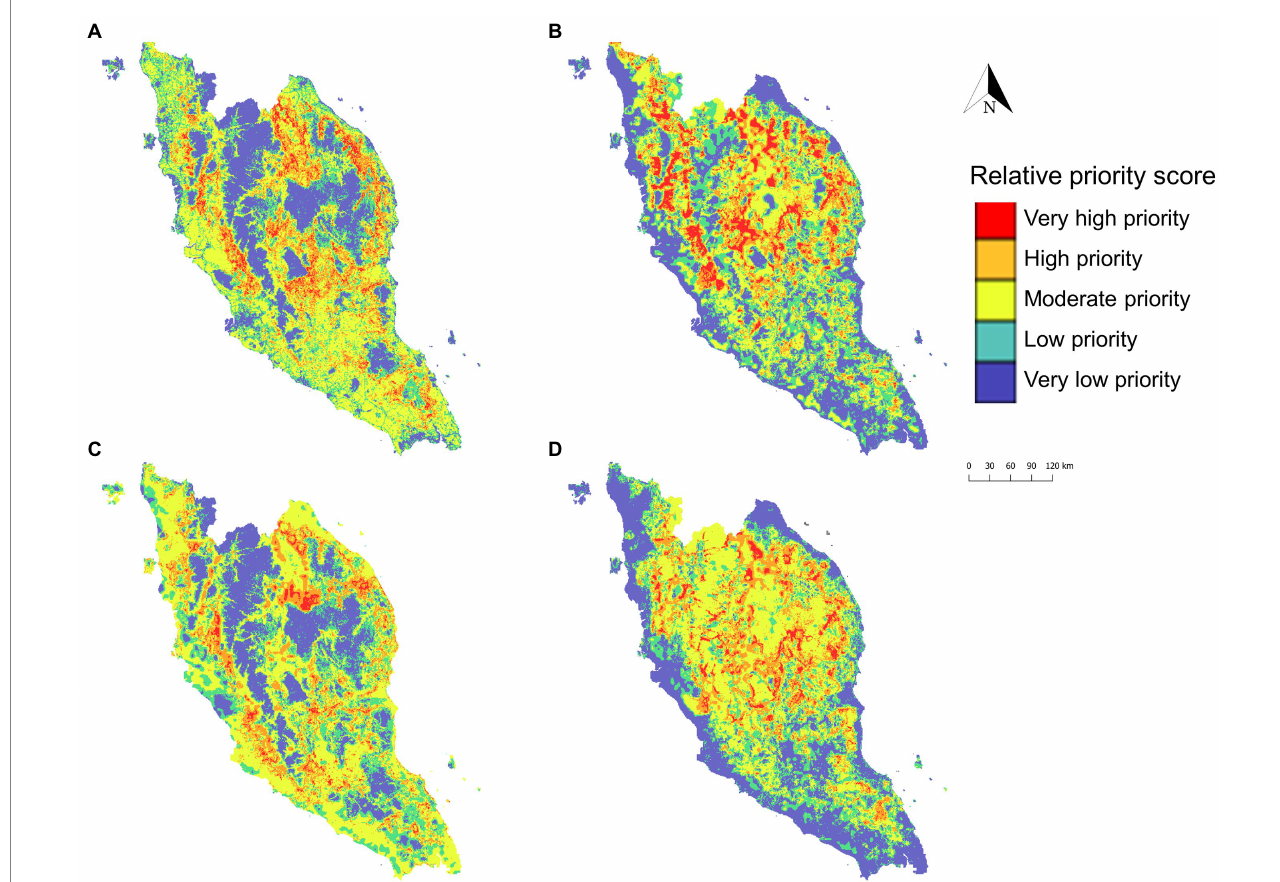
FIGURE 10 Priority zone maps developed to identify priority areas for intervention targeting agricultural and logging workers (A) , Anopheles Leucosphyrus group vector surveillance (B) , M. fascicularis surveillance (C) , and M. nemestrina surveillance (D) . The priority zone was determined using the sum of relative priority score of respective covariate spatial layer and XGBoost predicted risk of human knowlesi